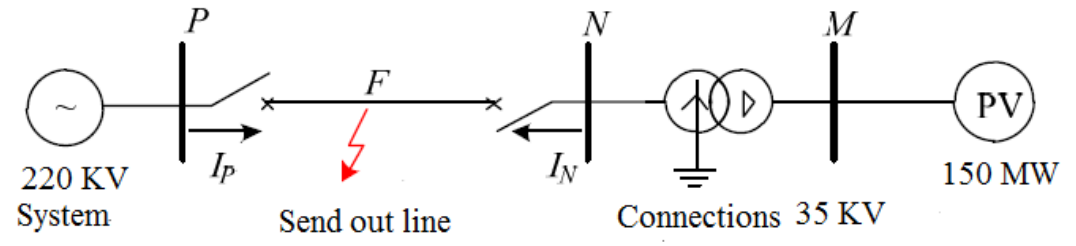
Figure 1. The model of the proposed system.